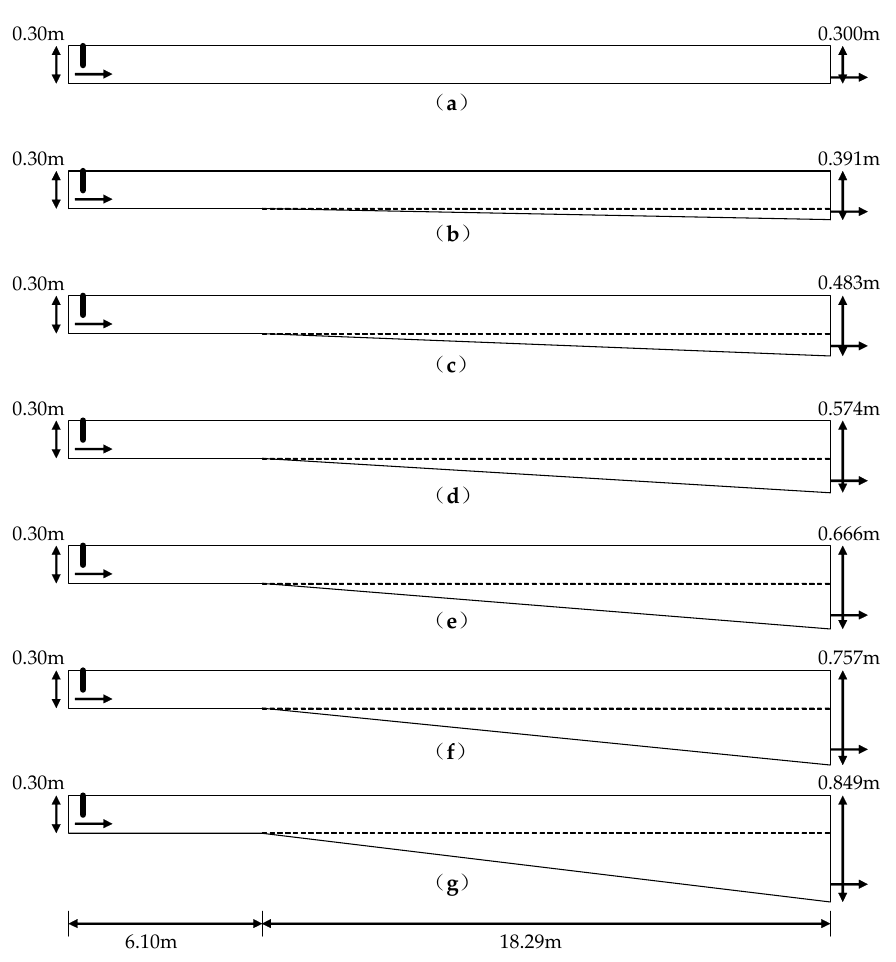
Figure 3. Sketch of reservoir models for different bottom slopes. ( a ) C1. ( b ) C2. ( c ) C3. ( d ) C4. ( e ) C5. ( f ) C6. ( g ) C7.